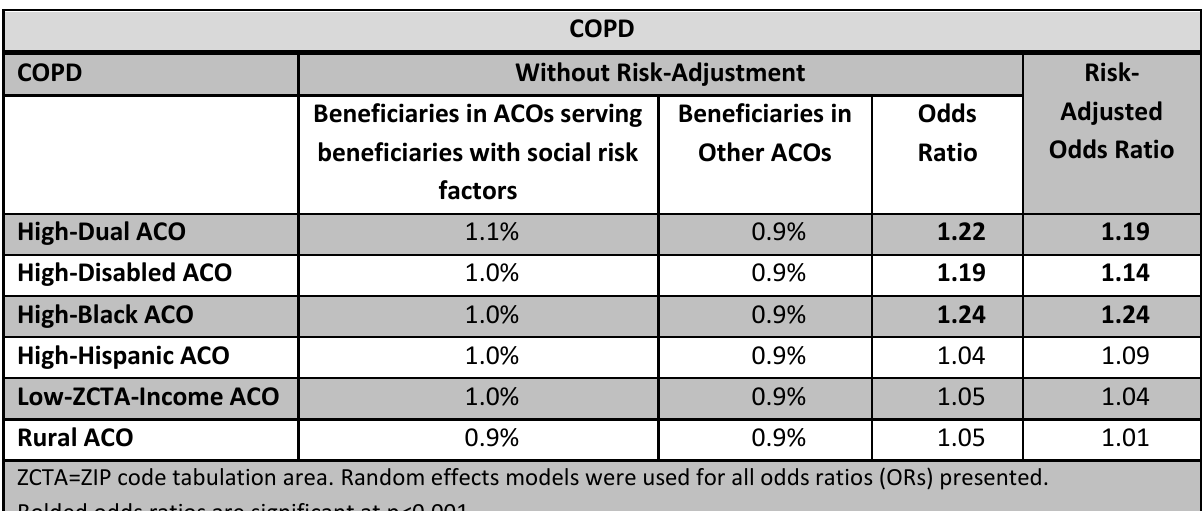
Table 9.6: ACO Social Risk Factors and Performance on Medicare Shared Savings Program PQI Measures